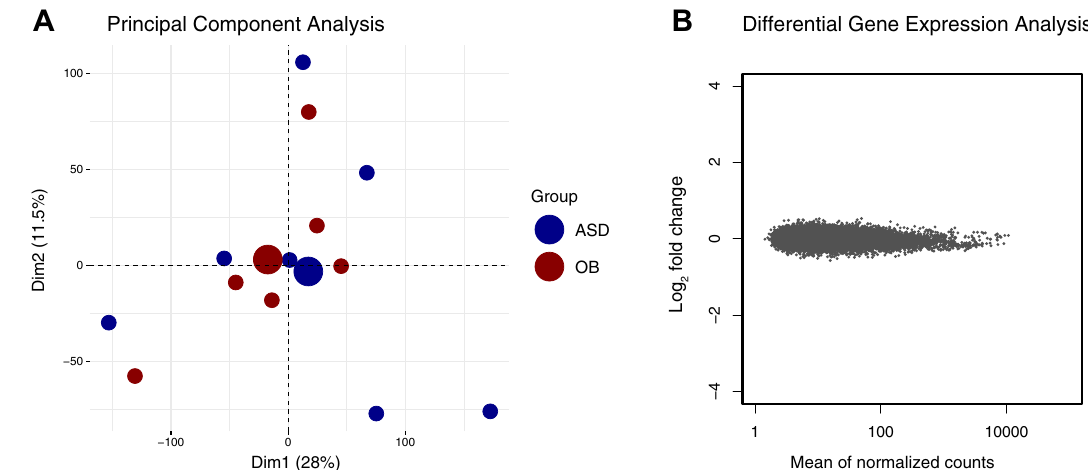
Figure 2. Transcriptional profile of iNKT cells from obese adolescents versus controls. ( A ) Principal component (PC) analysis of gene expression based on log2-transformed reads per million (RPM) following RNA sequencing, obese adolescents (n = 7) are red and age-and sex matched ASD controls are blue (n = 7). ( B ) MA plot showing no differential iNKT cell gene expression between obese adolescents and ASD controls (False Discovery Rate-corrected p <